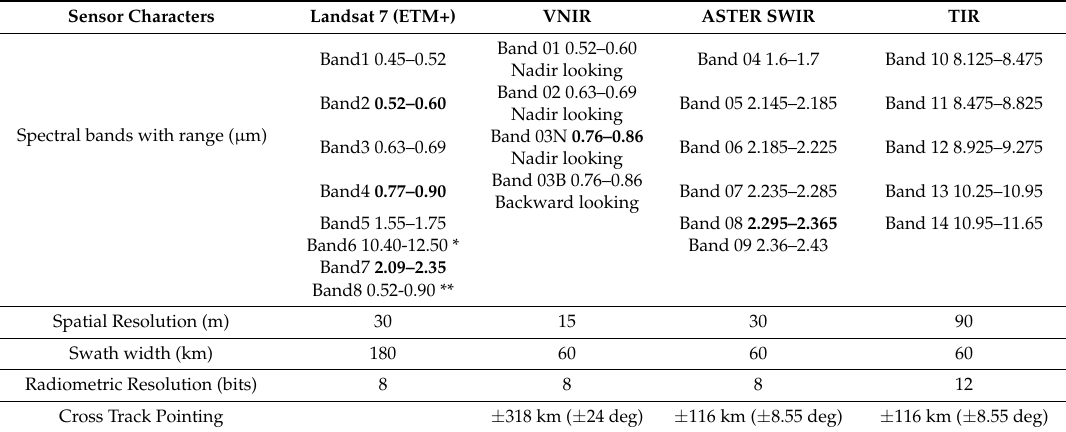
Table 1. Sensor characters of Landsat 7 (ETM+) and ASTER